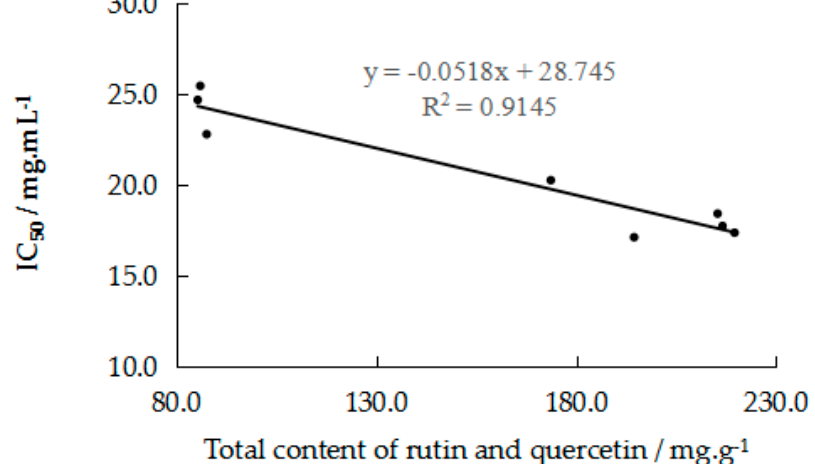
Figure 5. Relationship of the total contents of rutin and quercetin and IC 50 of samples.